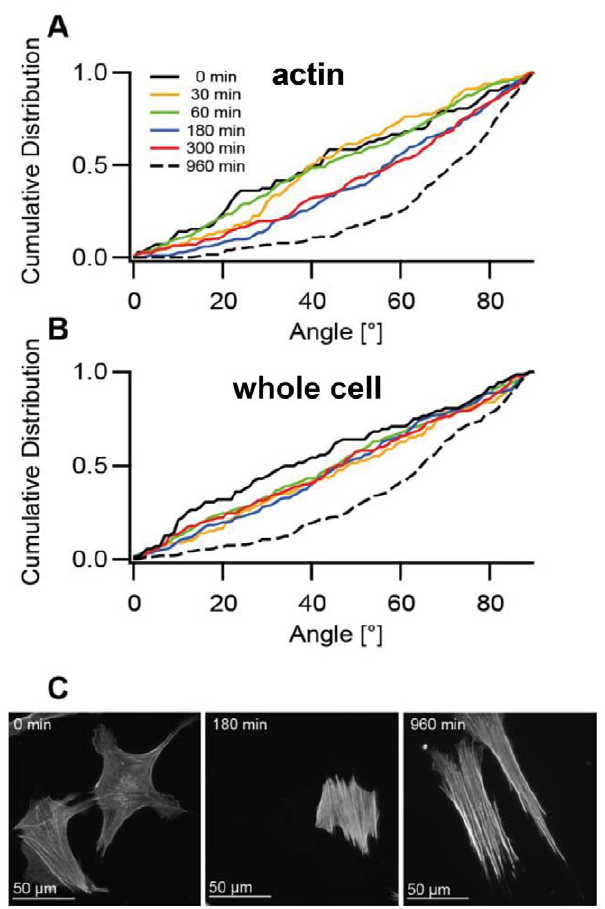
Figure 5. Time evolution of cytoskeletal (A, actin) and cell orientation (B, whole cell) upon cyclic strain of 11.8% amplitude (a 3 ). Control data (0 min) were taken on cells cultivated for 5 hours without applied strain. The final reorientation distribution in A and B is indicated by the dashed black line. Cell numbers in order of increasing duration: 72, 80, 227, 187, 159, and 261 cells. Note that for (A) all time points from 180 min and higher differ significantly from control while in (B) all distributions from 30 to 300 min equal random distributions (p=0.05 according to Kolmogorov-Smirnov test). The control distribution for 0 min is slightly shifted due to the relatively low number of cells evaluated for this time point. In (C) exemplary micrographs of cells stretched with amplitude a 3 for indicated times and subsequently labeled for actin are shown. Staining was done in parallel and microscope settings were kept identical to allow comparison of labeling intensities.